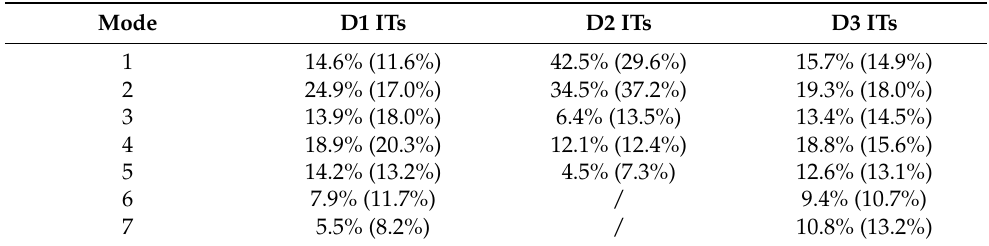
Figure 16. Time series of the depth-averaged modal KE (stacked areas) of coherent ( a , c , e ) and incoherent ( b , d , f ) components of the D1 ( a , b ), D2 ( c , d ), and D3 ( e , f ) ITs in OP3 at the mooring. The dark blue, orange, yellow, purple, green, light blue, and dark red indicate the first, second, third, fourth, fifth, sixth, and seventh baroclinic modes, respectively. Note that the modal KE has been low-pass filtered for 48 h to remove oscillations at its own frequency. Table 5. The proportions of kinetic energy densities in modes of the coherent and incoherent (in brackets) components of D1, D2, and D3 ITs.